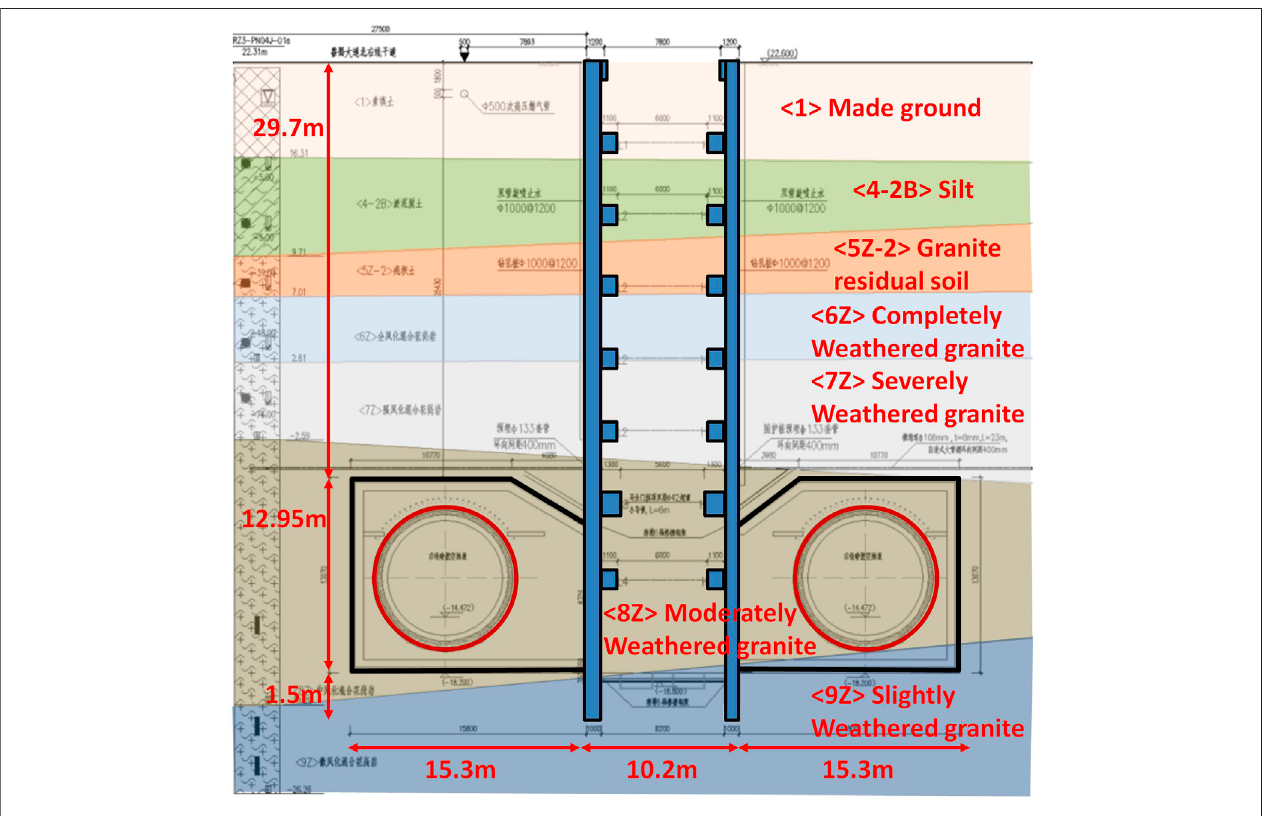
FIGURE 2 | Geological cross section at the temporary shaft location.